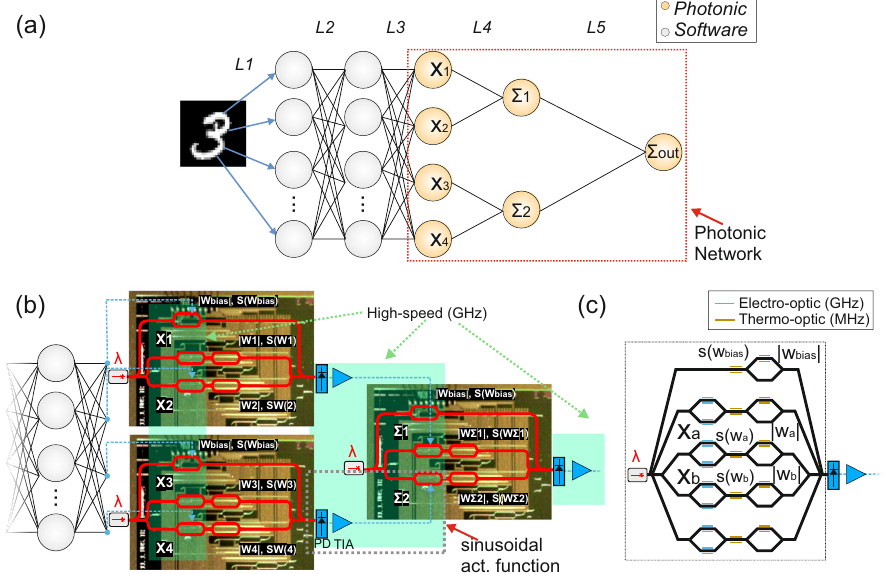
Fig. 1 | CPNN architecture andimplementation. a Layout of the proposed CPNN, ( b ) a close-up view of its integrated photonic part based on the dual-IQ coherent linear neuron architecture, with the electro-photonic activation function module